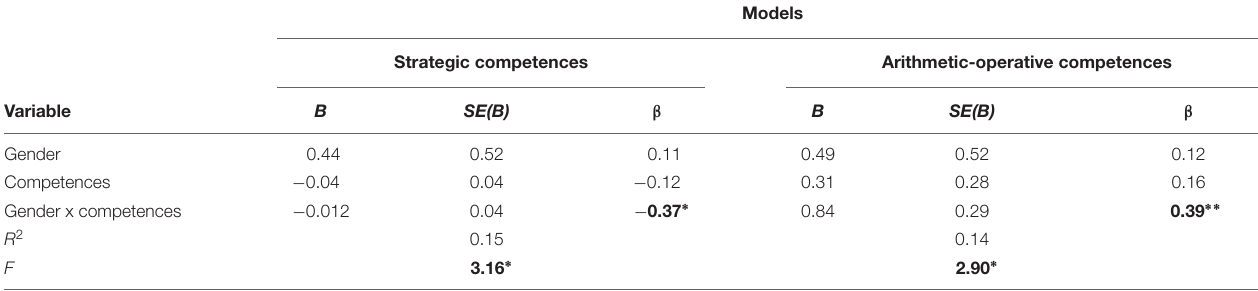
TABLE 4 | Regression models predicting mental effort ( N =